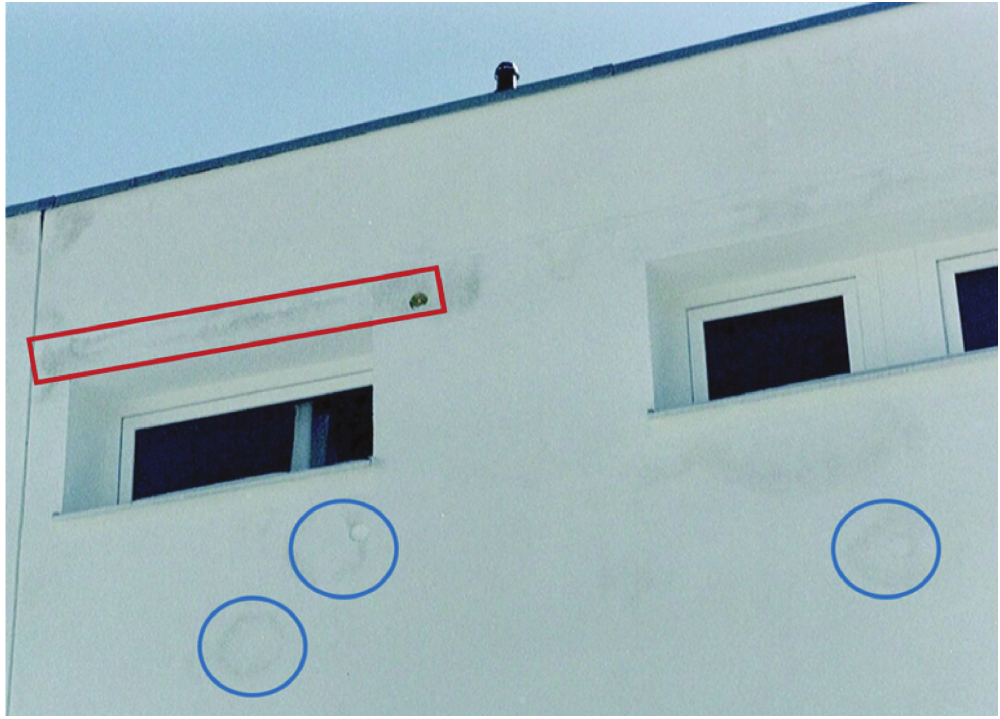
External wall insulation system on concrete. The construction moisture of the concrete caused staining on the rendered façade due to vapour diffusion from the wall through permeable zones of the EPS insulation layer. The vapour permeable zones above the windows (highlighted by a red rectangle) consist of mineral wool bars installed for fire safety; the round stains below the windows (indicated by blue circles) are caused by defective joints between the poorly installed EPS slabs